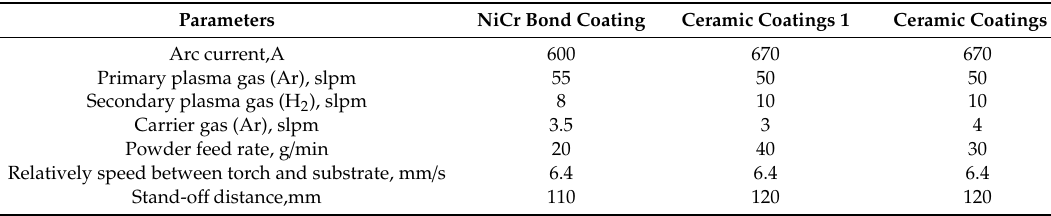
Table 1. Plasma spraying parameters operated in this study.